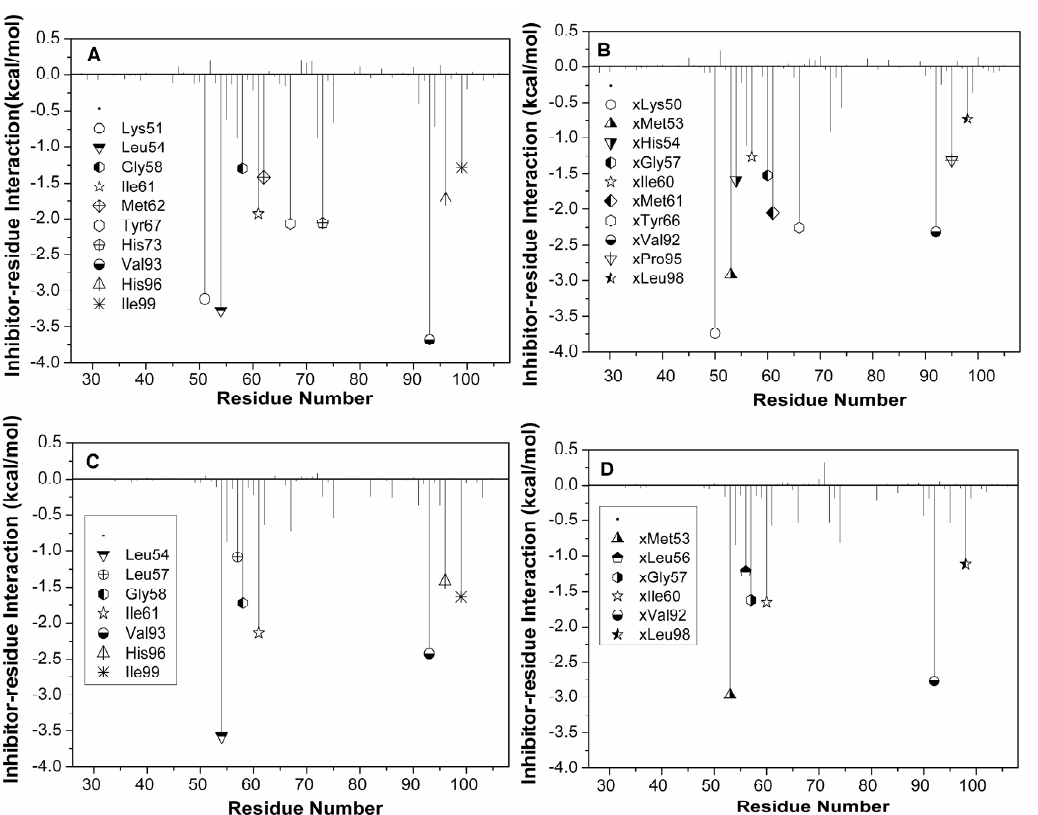
Figure 6. Inhibitor-residue interaction spectrum of ( A ) pDI6W-MDM2 complex; ( B ) pDI6W-MDMX complex; ( C ) WK23-MDM2 complex; and ( D )